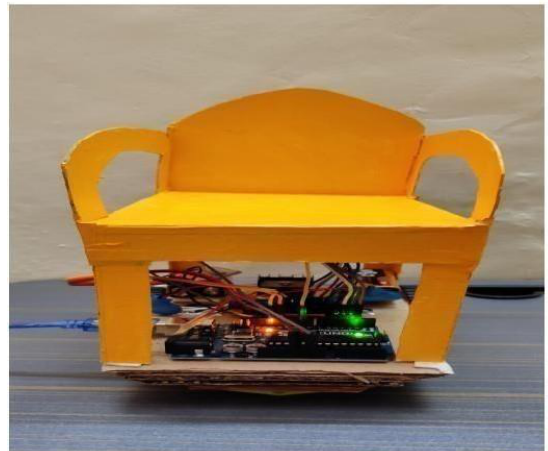
Fig. 5 Implementation of Proposed Circuit Model